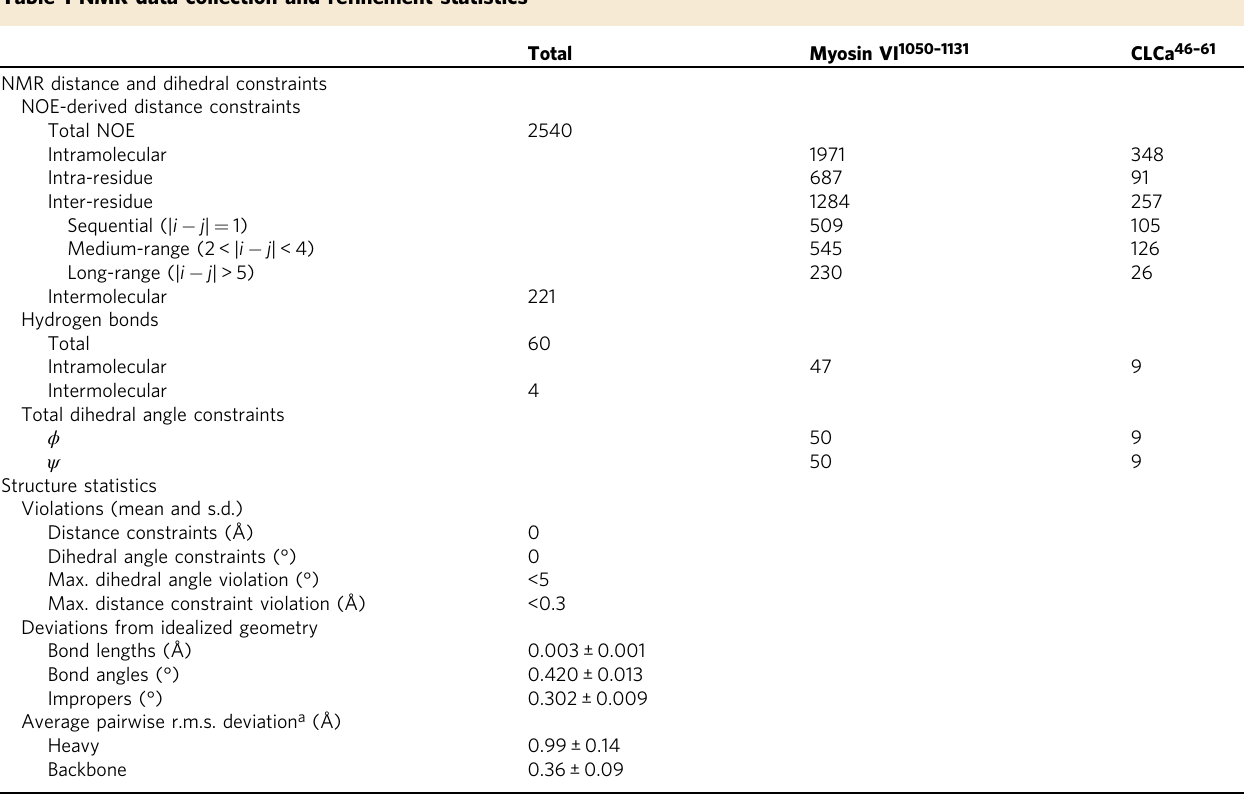
Table 1 NMR data collection and re fi nement statistics